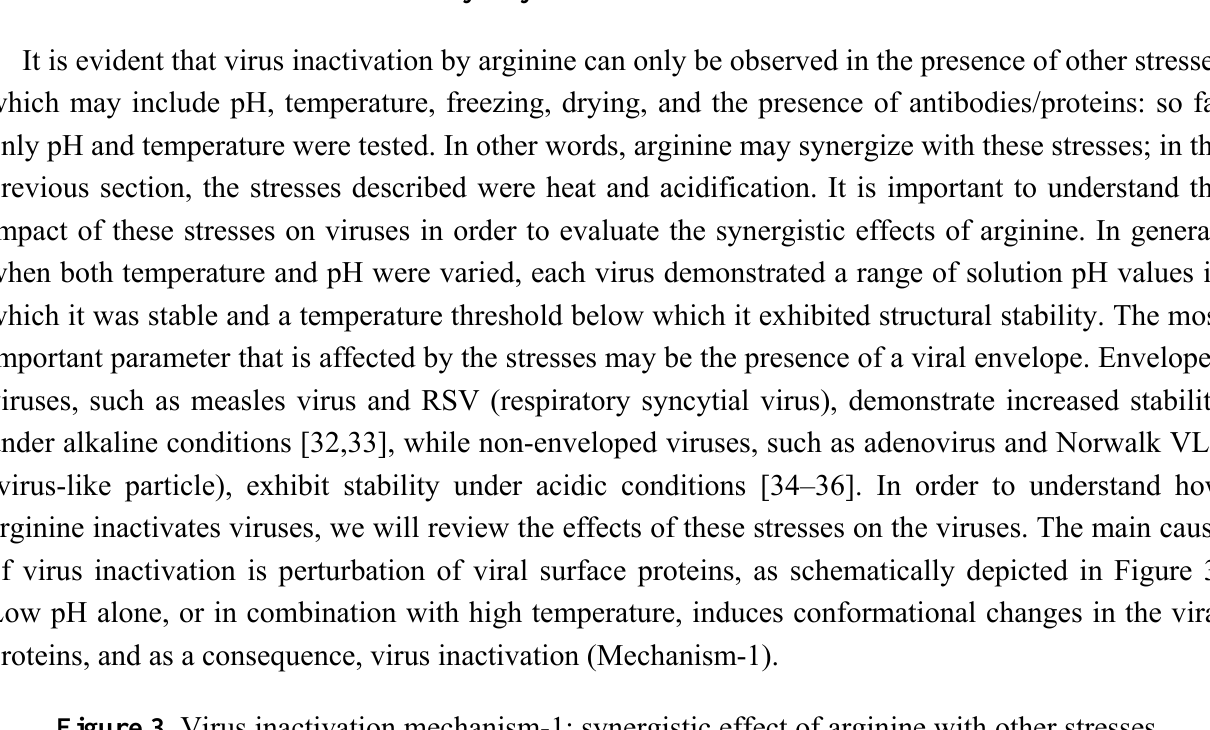
Figure 3. Virus inactivation mechanism-1: synergistic effect of arginine with other stresses causes structural changes in viral spike proteins leading to